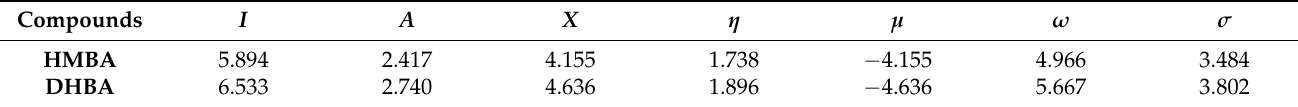
Table 4. Global reactivity parameters of HMBA and DHBA.